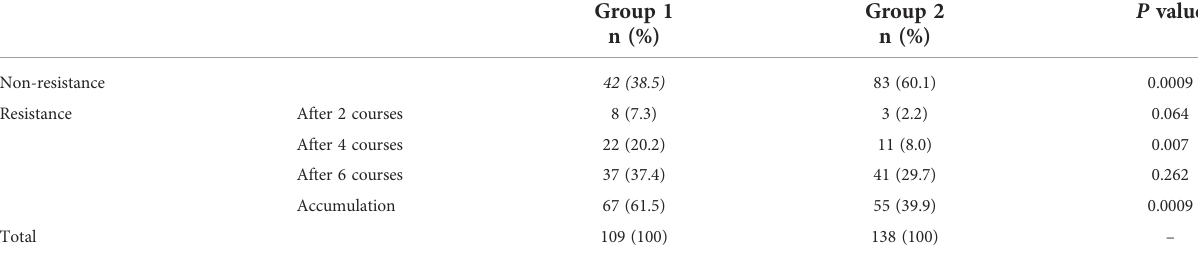
TABLE 3 Comparison of chemoresistance rates among different chemotherapy regimens.